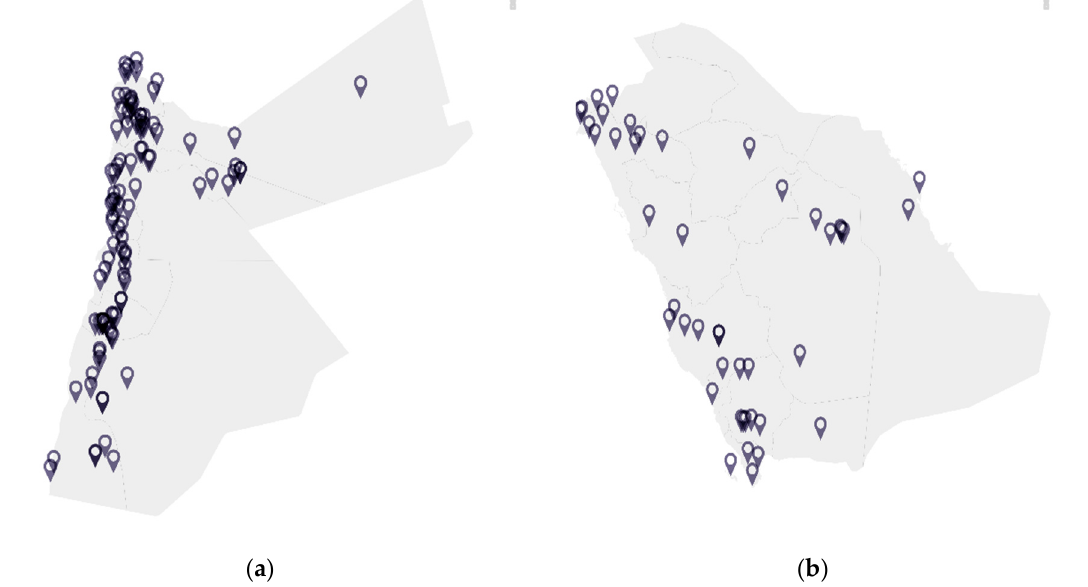
Figure 1. Distribution of bat species in ( a ) Jordan and ( b) Saudi Arabia.